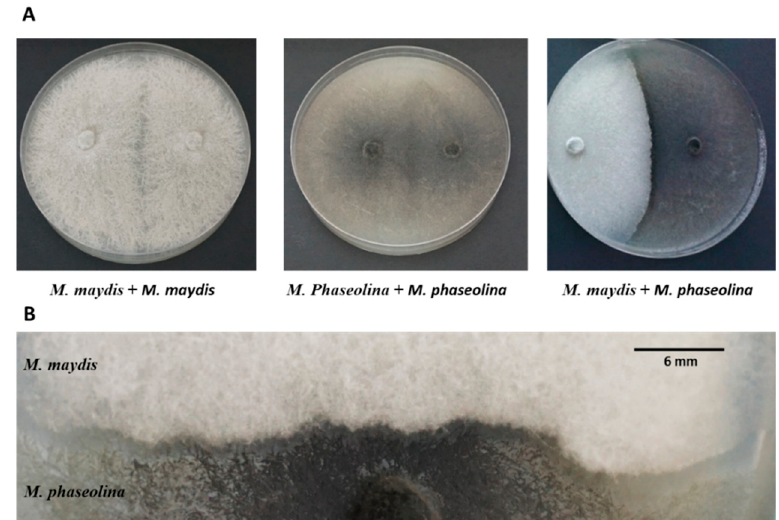
Figure 1. Plate confrontation assays. The plate assay to identify interactions between Magnaporthiopsis maydis and Macrophomina phaseolina in a rich potato dextrose agar (PDA) culture media. ( A ) Left panel— M. maydis was seeded on both sides of the Petri dish. Center panel— M. Phaseolina was seeded at both poles of the dish. Right panel—the two fungi were seeded opposite each other, M. maydis on the left, and M. phaseolina on the right. ( B ) Magnification of the confrontation line between maydis (upper white hyphae) and M. phaseolina (lower dark hyphae). The two colonies formed a clear line between them. Images were taken after six days of growth at 28 ˚ C ± 1 in the dark. Scale bar represents 6 mm.